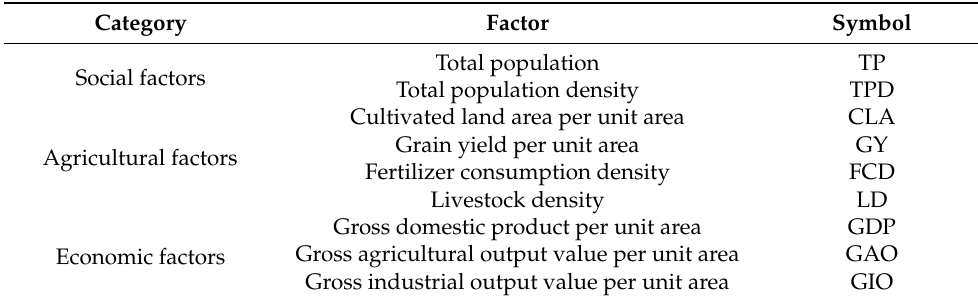
Table 1. Social–economic factors used for correlation analysis with NANI value and its